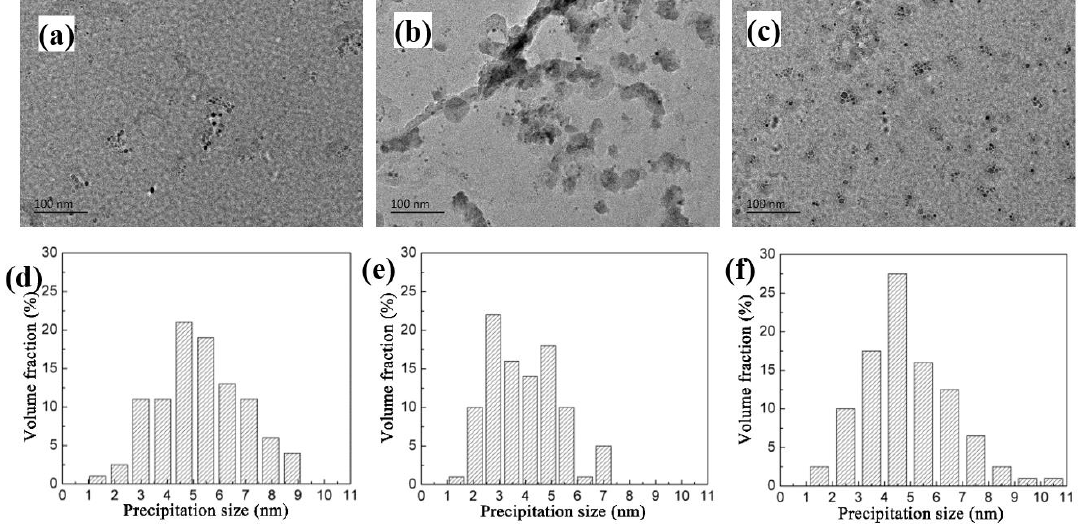
Figure 15. Precipitation and quantitative statistics of the (Ti, Nb)C under different Nb contents: ( a ) 06 Nb, ( b ) 09 Nb and ( c ) 11 Nb of precipitation morphology and distribution; ( d – f ) quantitative statistics of 06 Nb, 09 Nb, and 11 Nb, respectively.